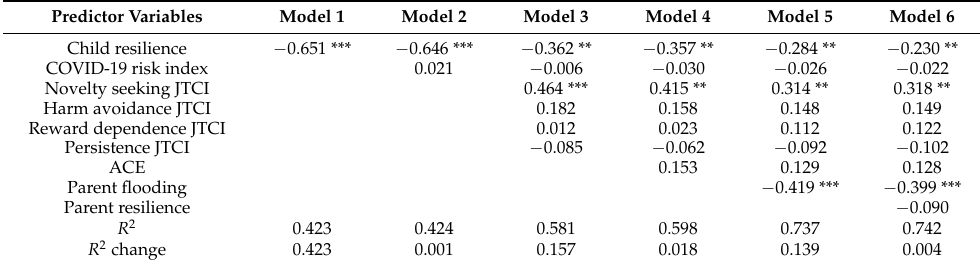
Table 4. Hierarchical regression analysis of predictors of total difficulties SDQ (boys only).